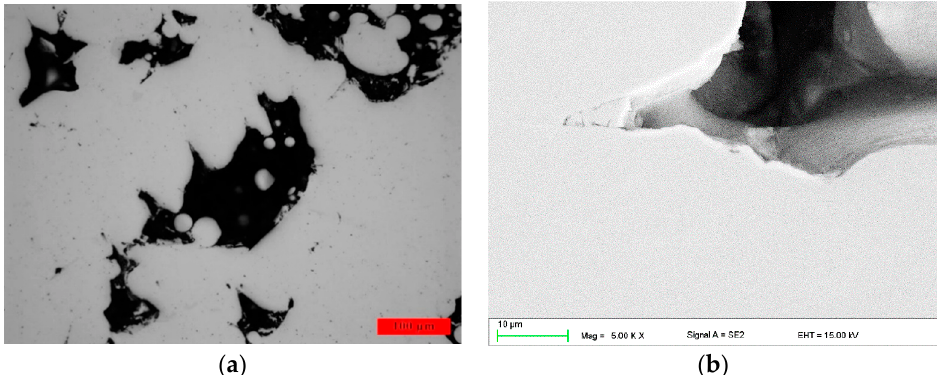
Figure 16. The structure of the Ti solid 8 specimen indicating the presence of fine sintered particles in individual pores as a result of incomplete sintering. ( a ) Light microscope; ( b ) SEM.